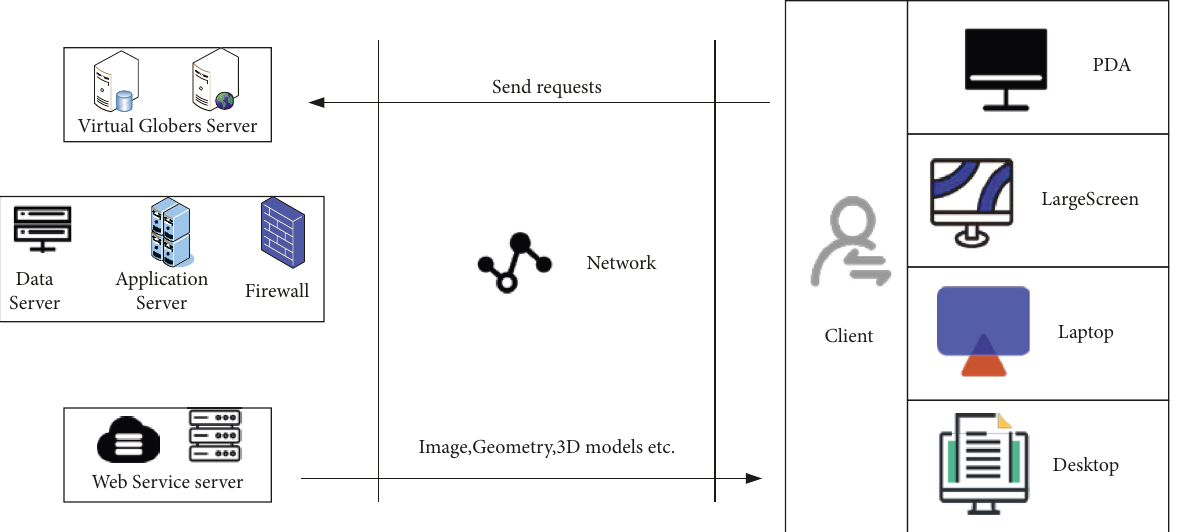
Figure 1: Architecture of cloud